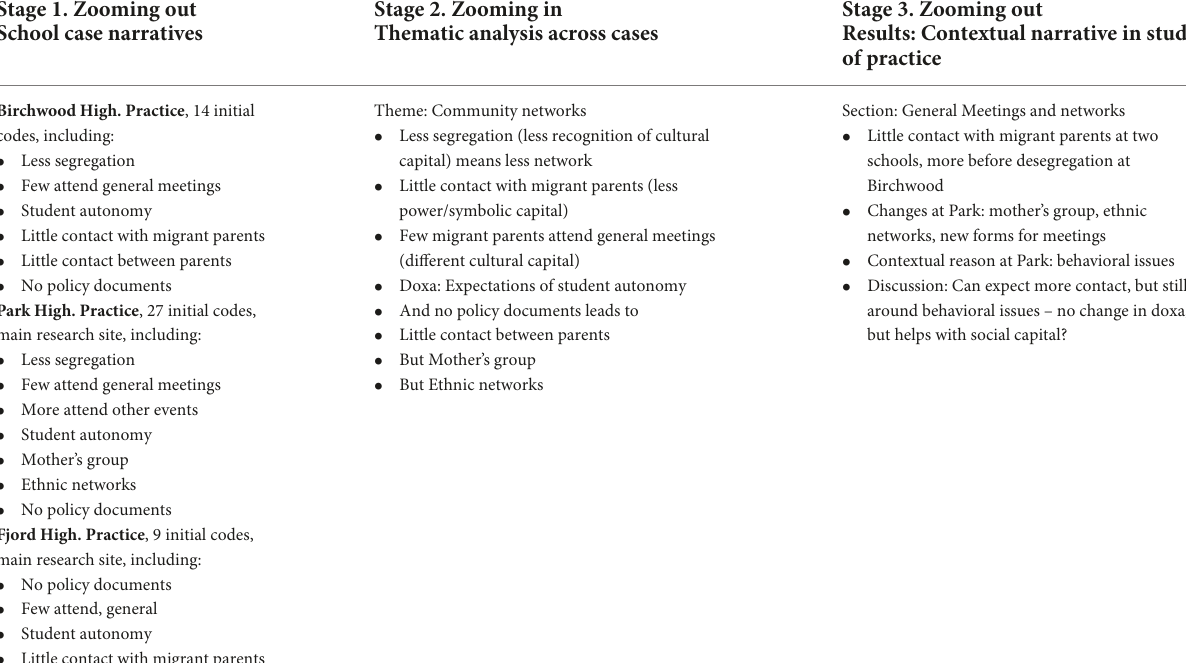
Stage 2. Zooming in Thematic analysis across cases